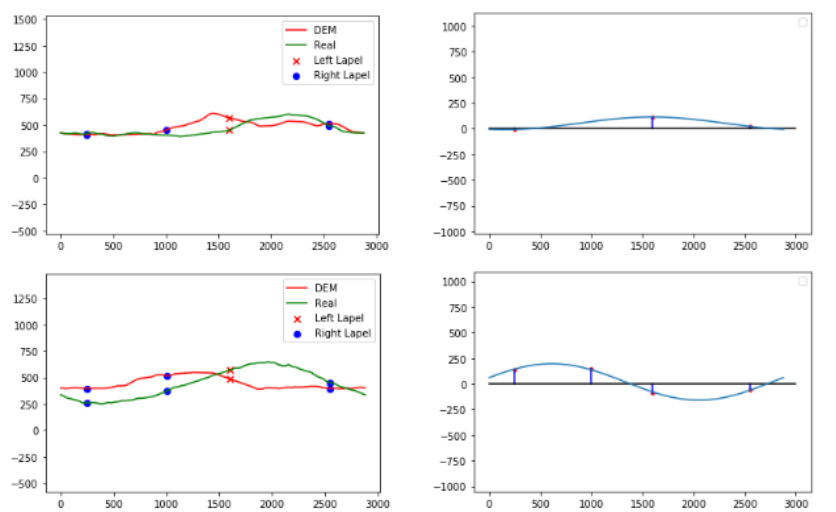
π − φ represents 2